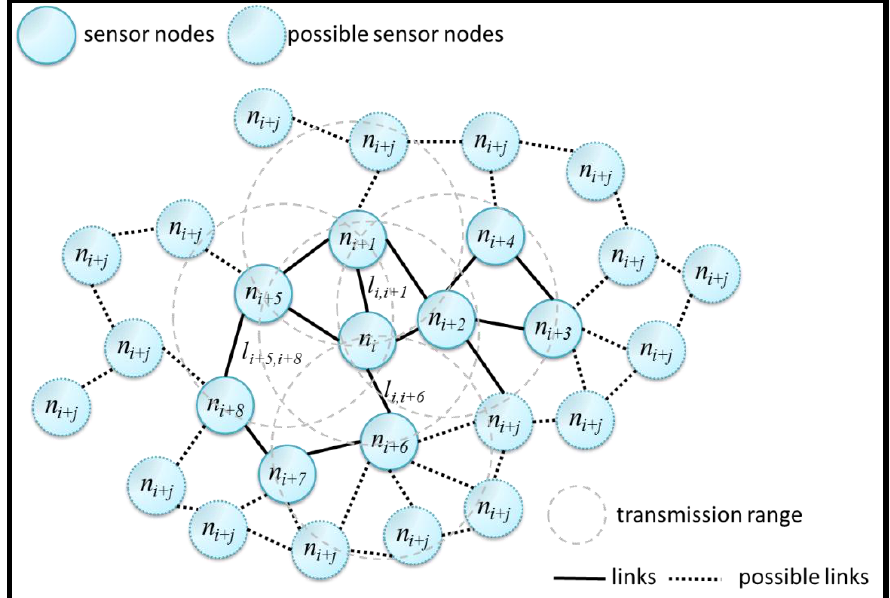
Figure 1. A graph of wireless sensor network.